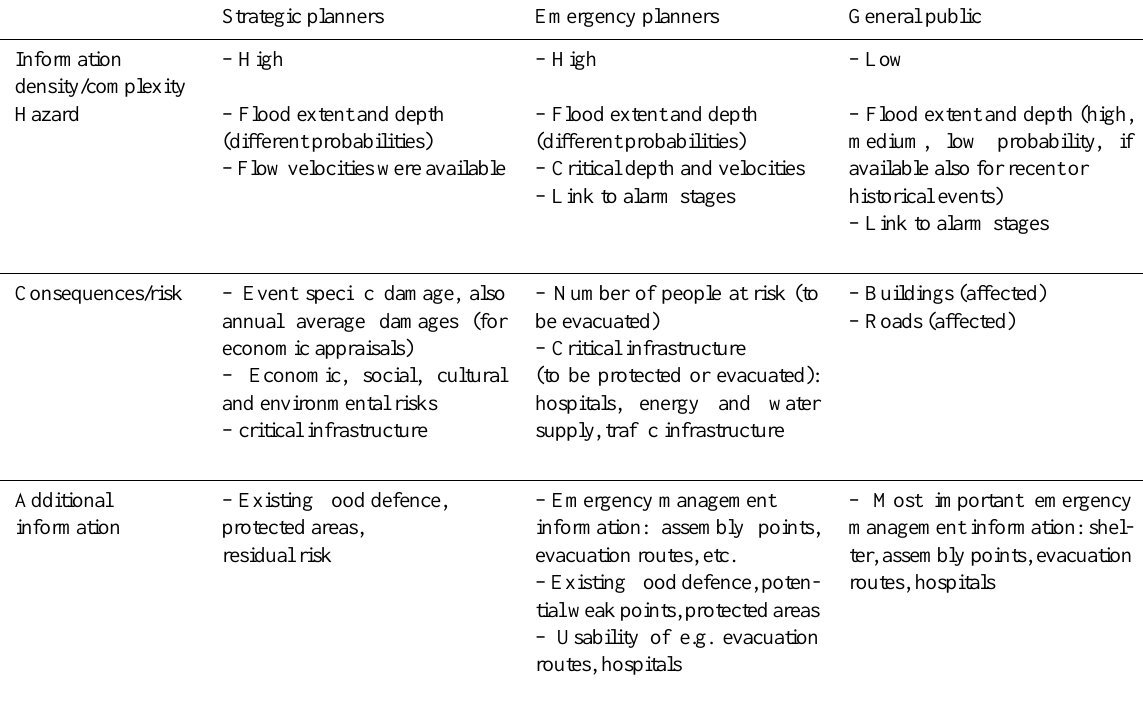
Table 3. Map contents required by different end-user